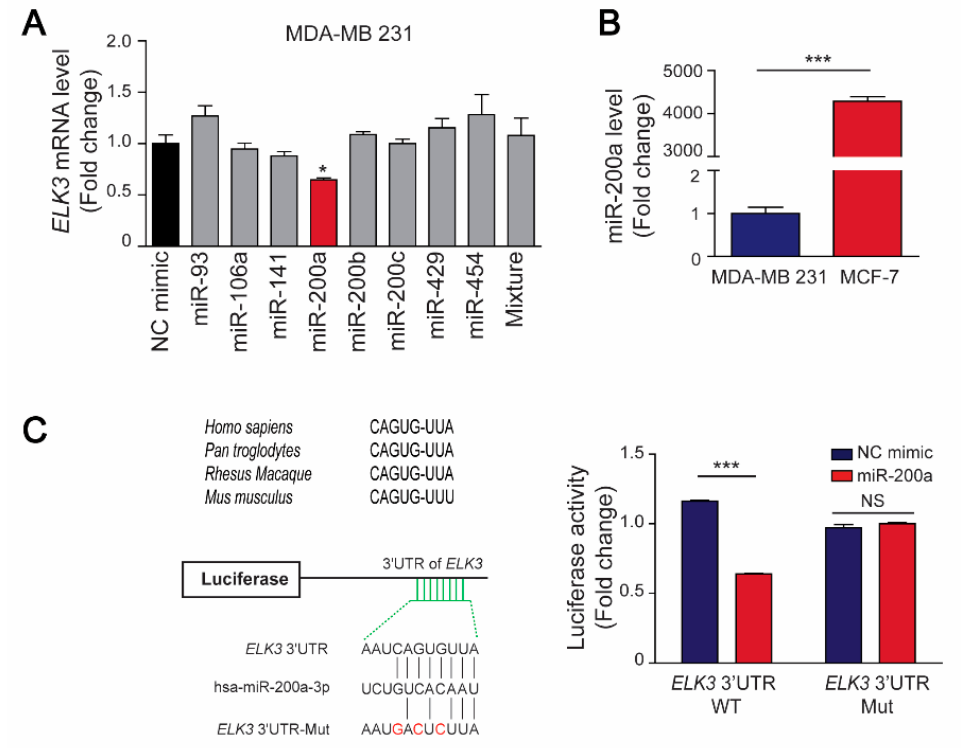
Figure 3. MiR-200a targets the 3’UTR of the ELK3 mRNA in breast cancer cells. ( A ) The indicated miRNAs (100 nM) were transfected into MDA-MB 231 cells for 48 h, and the ELK3 mRNA level was analyzed by qRT-PCR. Error bars represent the S.E.M.; * p < 0.05 (Student’s t -test). ( B ) Quantitative analyses of miR-200a expression in MCF7 and MDA-MB 231 cells. Error bars represent the S.E.M.; *** p < 0.001 (Student’s t -test). ( C ) Regulation of the luciferase activity of a reporter plasmid containing the wild-type or mutated 3’UTR of the ELK3 mRNA by miR-200a. ELK3 3’UTR Mut indicates mutation of the miR-200a target sequences. Luciferase activity was measured after co-transfection of MDA-MB 231 cells with a miR-200a mimic and the indicated luciferase reporter plasmids for 48 h. Error bars represent the S.E.M.; *** p < 0.001 (Student’s t -test). 2.4. miR-200a Expression Negatively Correlates with that of the ELK3 mRNA Level in Breast Cancer Cells To extend our understanding of the negative association between miR-200a and ELK3 in breast cancer, we analyzed the expression patterns of miR-200a, and the ELK3 mRNA in other breast cancer cells and human breast cancer patient samples. A bioinformatics analysis of ELK3 and miR200a data in a previous report [24] revealed high expression of ELK3 and low expression of miR-200a in claudin low-type TNBC cells, including MDA-MB 231 and Hs578T cells. On the other hand, luminal-type breast cancer cells, including MCF7 cells, showed opposing patterns of ELK3 and miR-200a expression (Figure 4A). Next, we used published data from The Cancer Genome Atlas (TCGA) to analyze breast cancer patient samples and found that miR-200a expression was negatively correlated with that of the ELK3 mRNA in 747 breast cancer patient samples. This negative correlation was found in 415 luminal breast cancer-type samples and 118 TNBC-type samples (Figure 4B). These findings suggest that miR-200a is a negative regulator of the ELK3 mRNA level in breast